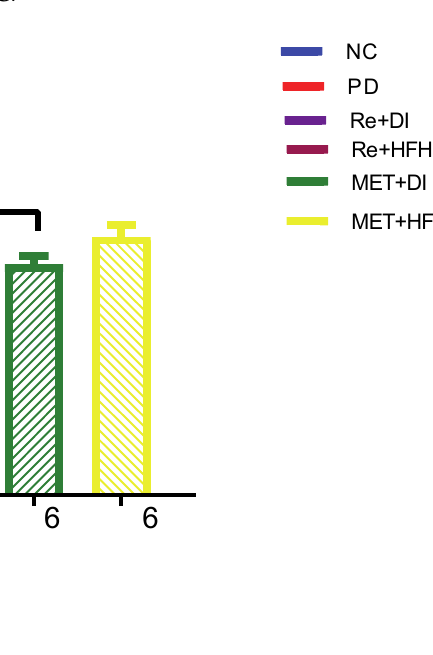
Figure 6. TNF α in normal control (NC), prediabetic control (PD), metformin and diet interven- tion (MET + DI), metformin and high-fat/high-carbohydrate diet (MET + HFHC), rhenium (V) com/pound and diet intervention (Re + DI), and rhenium (V) compound and high-fat/high- carbohydrate diet (Re + HFHC) groups after 12 weeks of treatment. Values are presented as means ± SEM (n = 6). (cid:70) p < 0.05 in comparison with NC; # p < 0.05 in comparison with PD, MET + DI, MET + HFHC, Re + DI and Re + HFHC.